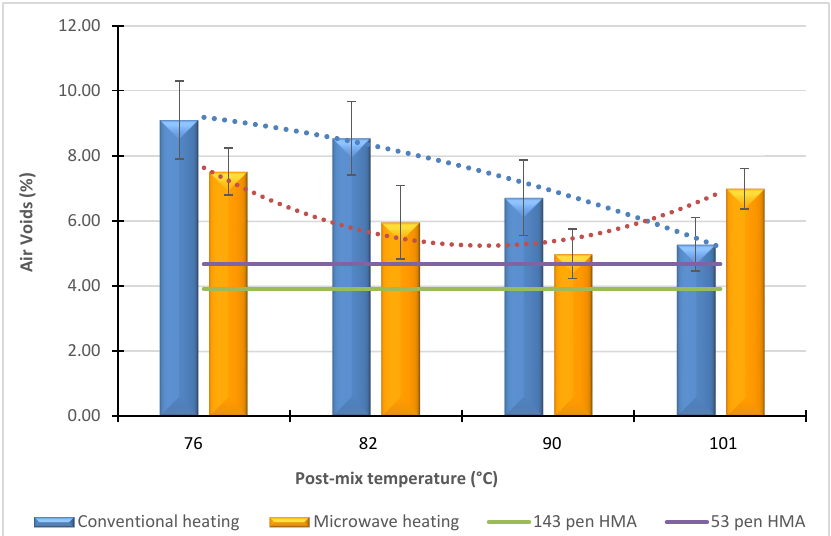
Figure 3. Impact of post-mix time on air void of CBEMs containing 5.5% PSA .